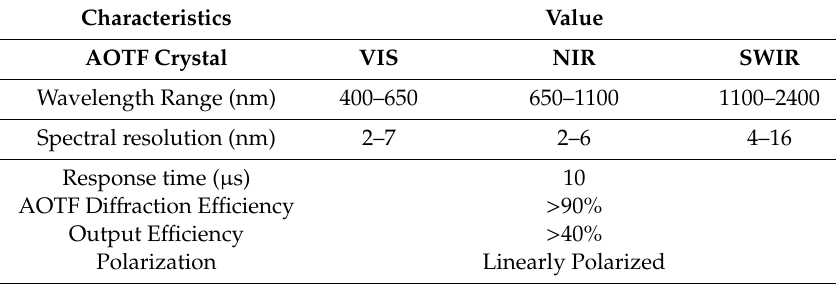
Table 1. YSL ® acousto-optic tunable filter (AOTF) major parameter specifications.